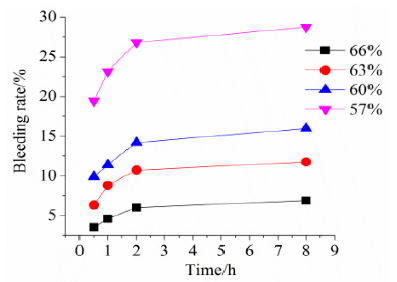
Figure 8. Effect of the different solid concentrations on slurry bleeding rate.